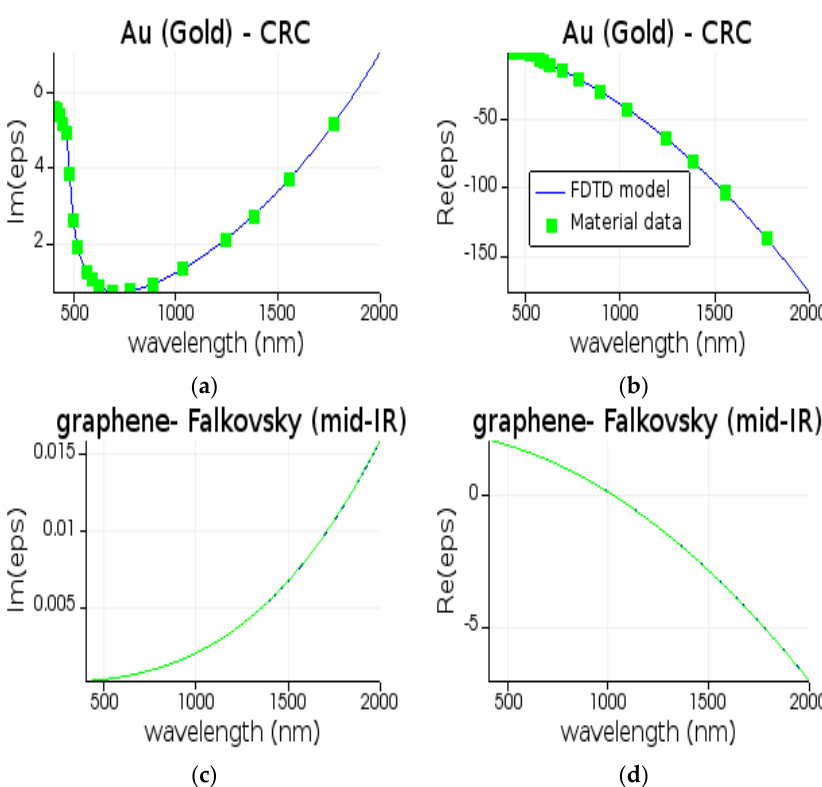
Figure 2. Imaginary and real part of Au permittivity ( a,b ) and of graphene ( c,d ) as a function of wavelength in Vis-NIR region (0.4–2 µm).